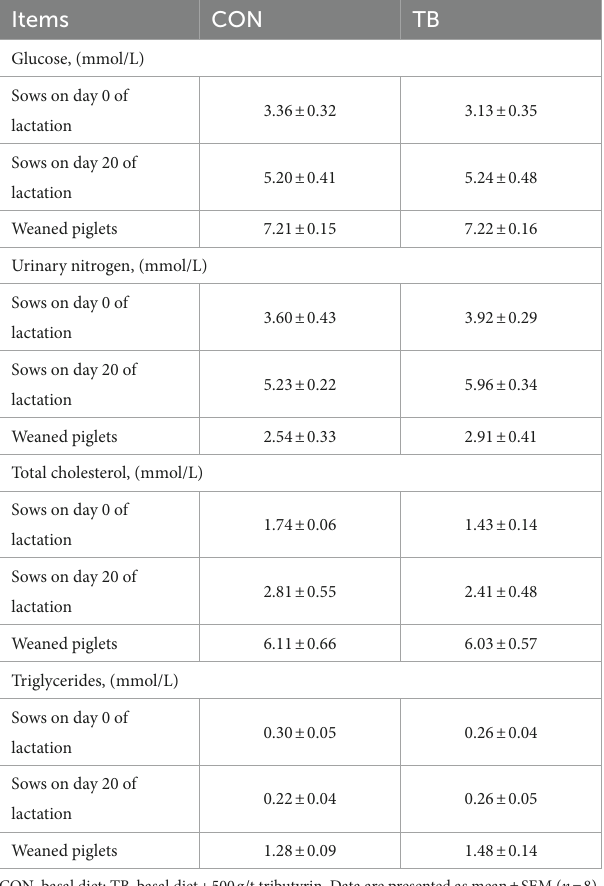
TABLE 7 Effects of tributyrin on blood hormone secretion in sows.